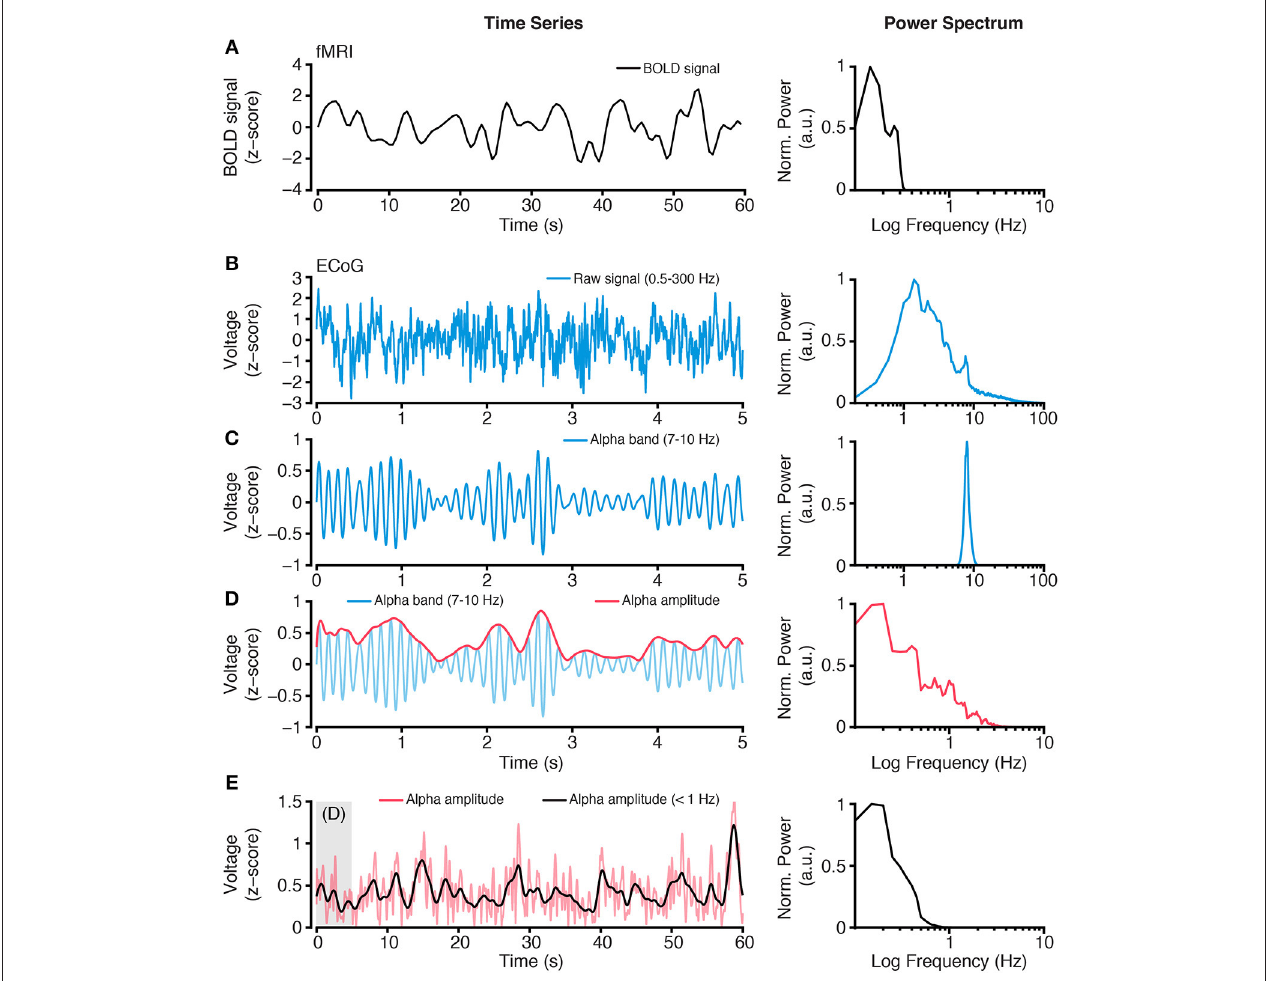
FIGURE 2 | Extracting slow time scale variability of rapid electrophysiological dynamics. (A) BOLD fMRI activity is a slow time varying signal, due to its hemodynamic basis. Plot shows an example time course of BOLD fMRI activity (left) and the power spectrum of this signal (right). Together these plots highlight the low frequency ( < 1Hz) content of BOLD fMRI. (B) In contrast, electrophysiological activity, such as ECoG, has a wide spectral content. However, standard ECoG recordings apply a high-pass filter limiting the study of ultra slow time scales (but see Palva and Palva, 2012). Plots show a raw ECoG time series (left), with a band pass range 0.5–300Hz, and its power spectrum (right). The power spectrum shows a lack of power at lower frequencies ( < 1Hz), owing to the recording filters, and a progressive decrease in power for higher frequencies, as commonly observed. (C) To study frequency specific activity patterns and inter-regional correlations, raw time series are filtered to isolate the frequency range of interest. Plots show an alpha range filtered time series (left), with a band pass of 7–10Hz, and its power spectrum (right). The isolated alpha band activity is a rapid time varying signal, however the amplitude of alpha activity shows a slower rate of change. (D) Plots show the amplitude (red, left) of the alpha band time series from (C) and its power spectrum (right). Because the alpha band amplitude time course is not subject to the filtering of the recorded raw signal, it can contain lower frequency spectral content. (E) Typically, BOLD fMRI activity > 1Hz is excluded because it contains a number of non-hemodynamic artifacts (Power et al., 2014). To more closely align the time scales of hemodynamic and electrophysiological activity, the alpha band amplitude signal can be low pass filtered < 1Hz, to obtain a time series with similar spectral content as BOLD fMRI. Plots show the time course of alpha band amplitude (red) and its low pass filtered form (black; left). The power spectrum (right) of the slow time varying alpha band amplitude shows similar spectral content as the BOLD signal. As reviewed, this approach of focusing on slow time scale modulations of higher frequency activity provides a successful means of comparing hemodynamic and electrophysiological activity. Importantly, this approach can be applied to any electrophysiological frequency range of interest, and allows comparison across frequencies (Nir et al., 2008; Wang et al., 2012; Foster et al., 2015). All power spectra are calculated from extended time series from which example epochs are shown, and are normalized to the spectral maxima, with frequency shown on a log